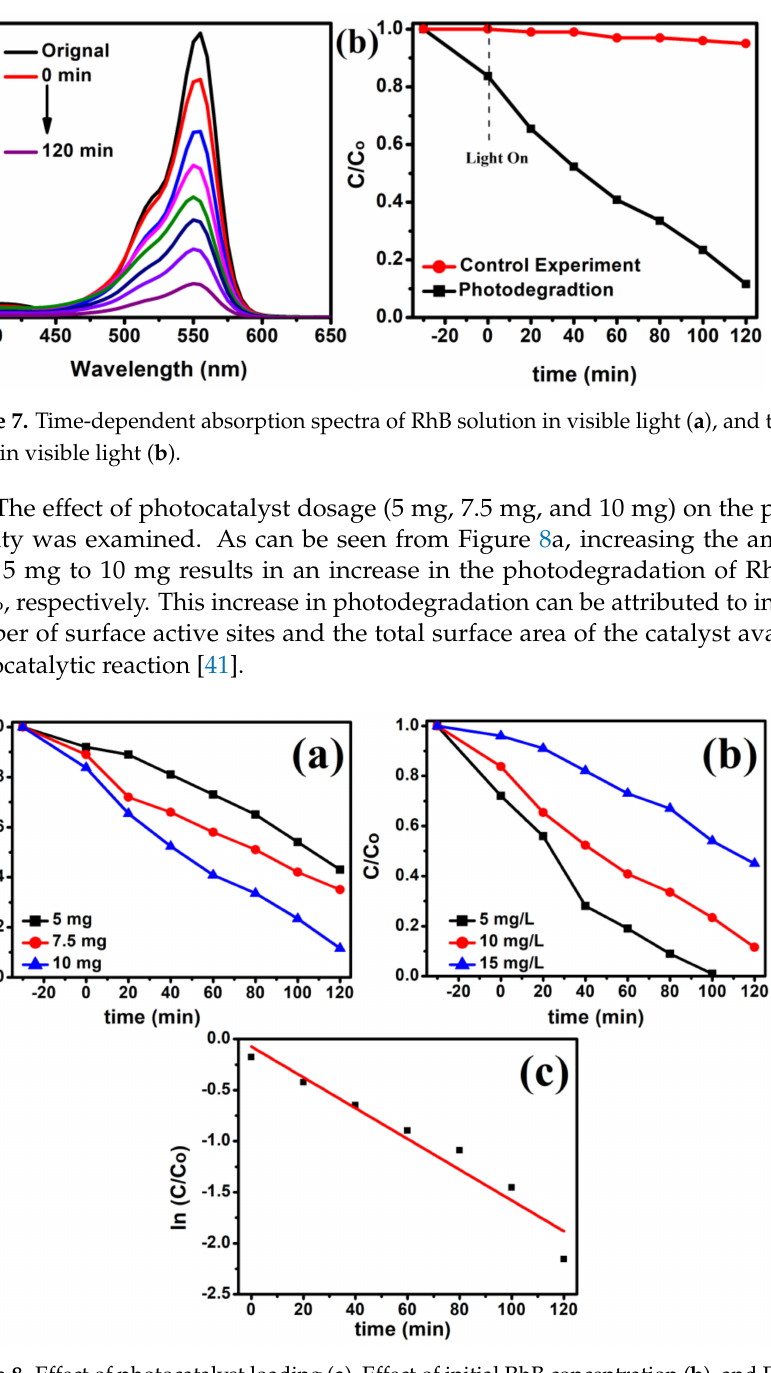
Figure 8. Effect of photocatalyst loading ( a ), Effect of initial RhB concentration ( b ), and Plot of ln (Co/C) vs. time ( c ) (10 mg photocatalyst, 10 mg/L RhB dye, Room temperature, 300 W incandescent